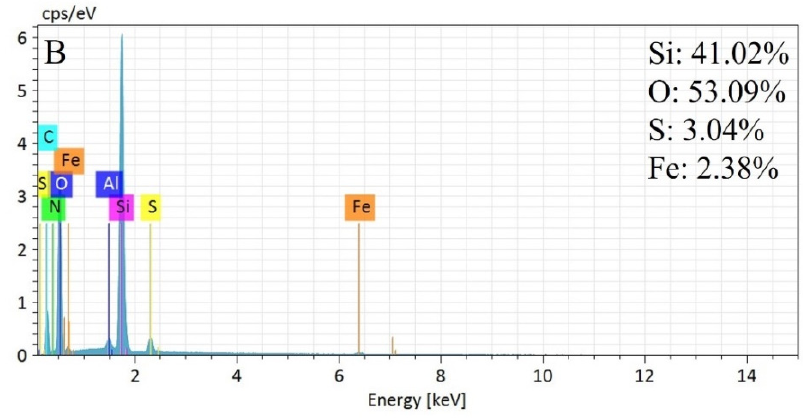
Figure 2. Element distribution spectra for MSNs ( A ) and MSN-SS-Fc ( B ).